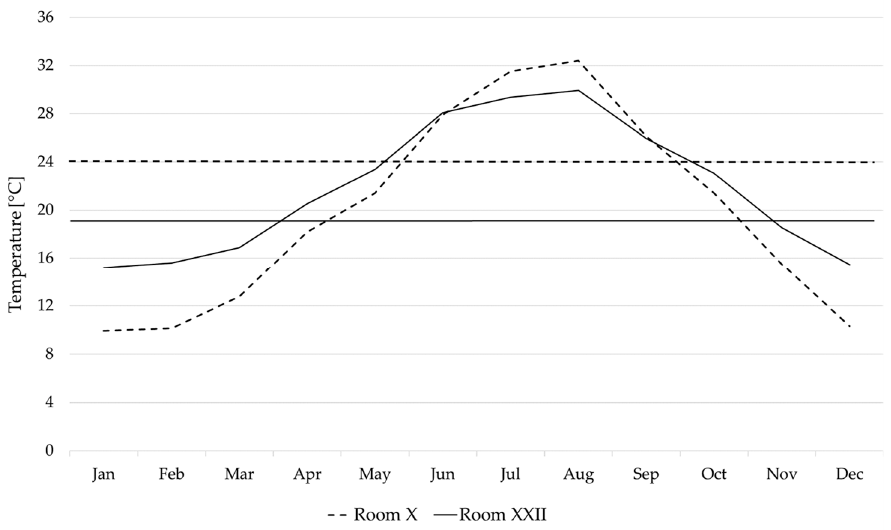
Figure 20. Trend of monthly and annual (horizontal line) mean values of T for rooms X and XXII.